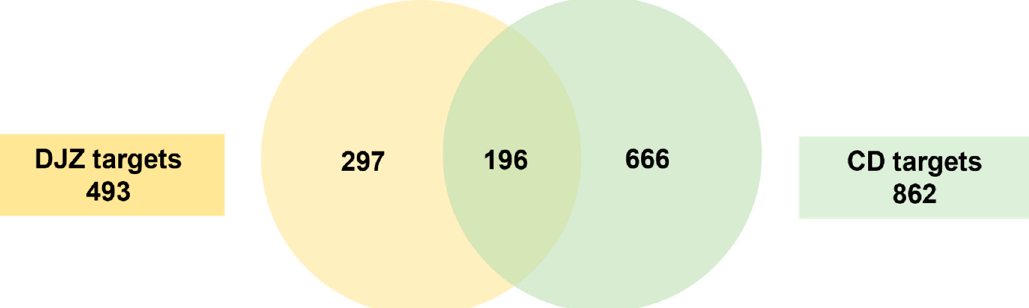
Figure 2. Venn diagram of DD and CD targets. DD, Dajianzhong decoction; CD, Crohn’s disease.